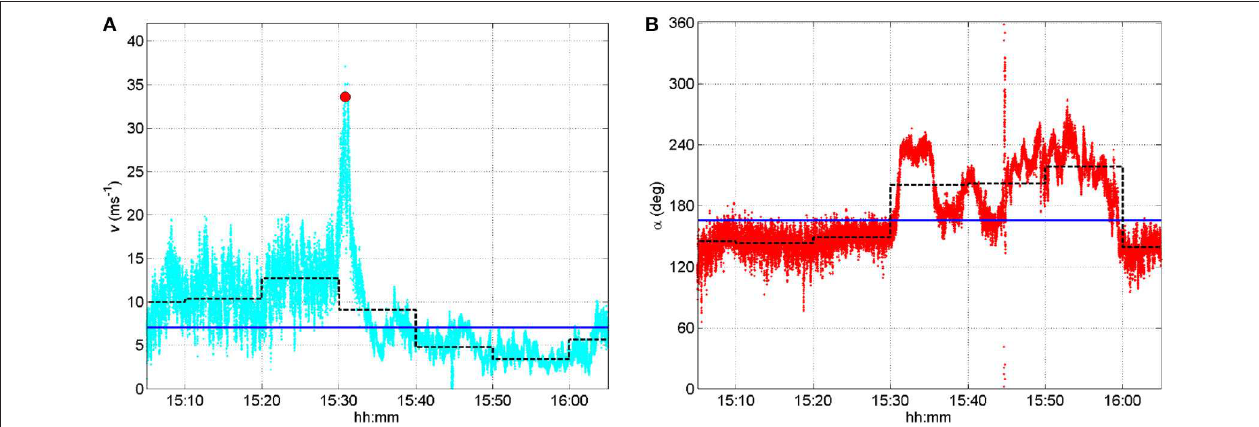
FIGURE 1 | Wind speed (A) and direction (B) recorded on 25 October 2011 in the Port of La Spezia. Reproduced from De Gaetano et al. (2014) with permission from Elsevier.